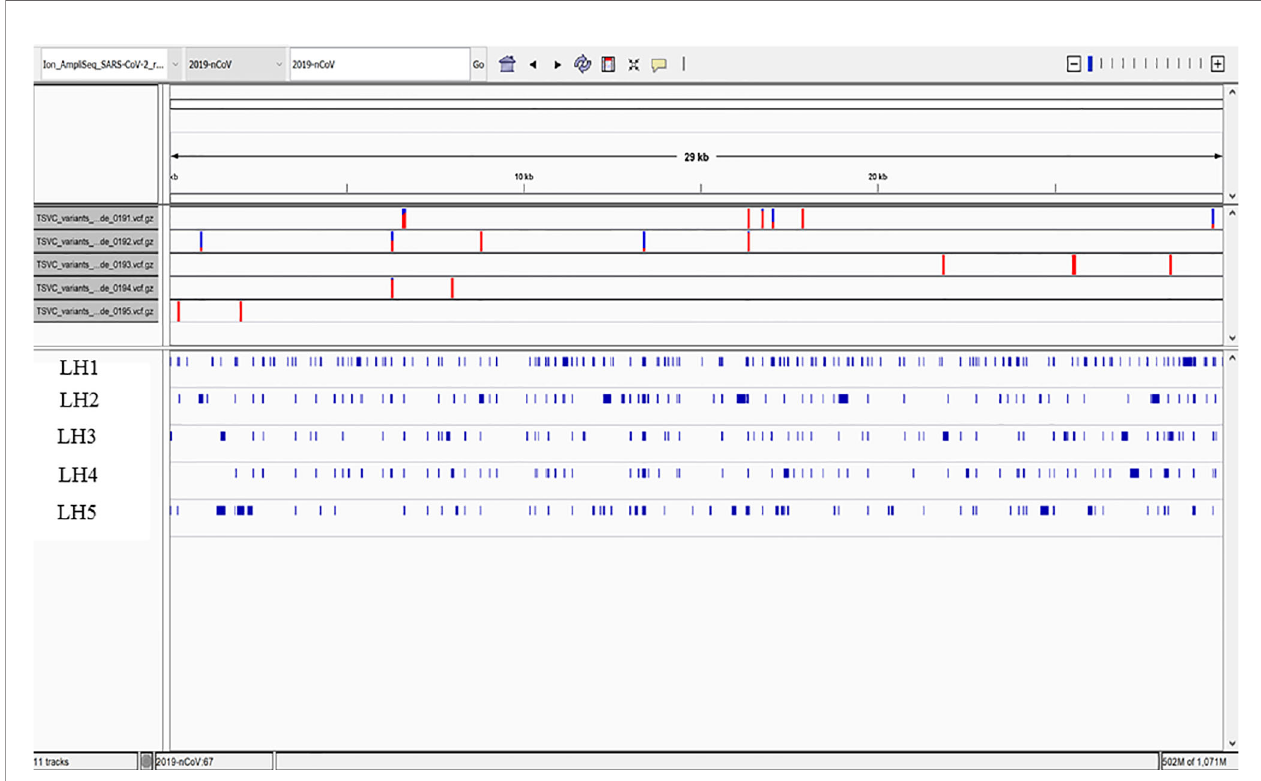
FIGURE 5 | High Quality Mutations in the Callable Regions. Only fragmented viral RNA was identi fi ed in the fi ve patients, but multiple mutations throughout the viral genome were identi fi ed, the vast majority of which were unique to each patient. Overall coverage was less than 20%, and no complete sequence in any portion of the viral genome was detected, including in the spike gene encoding the S1 subunit identi fi ed by protein analysis in these